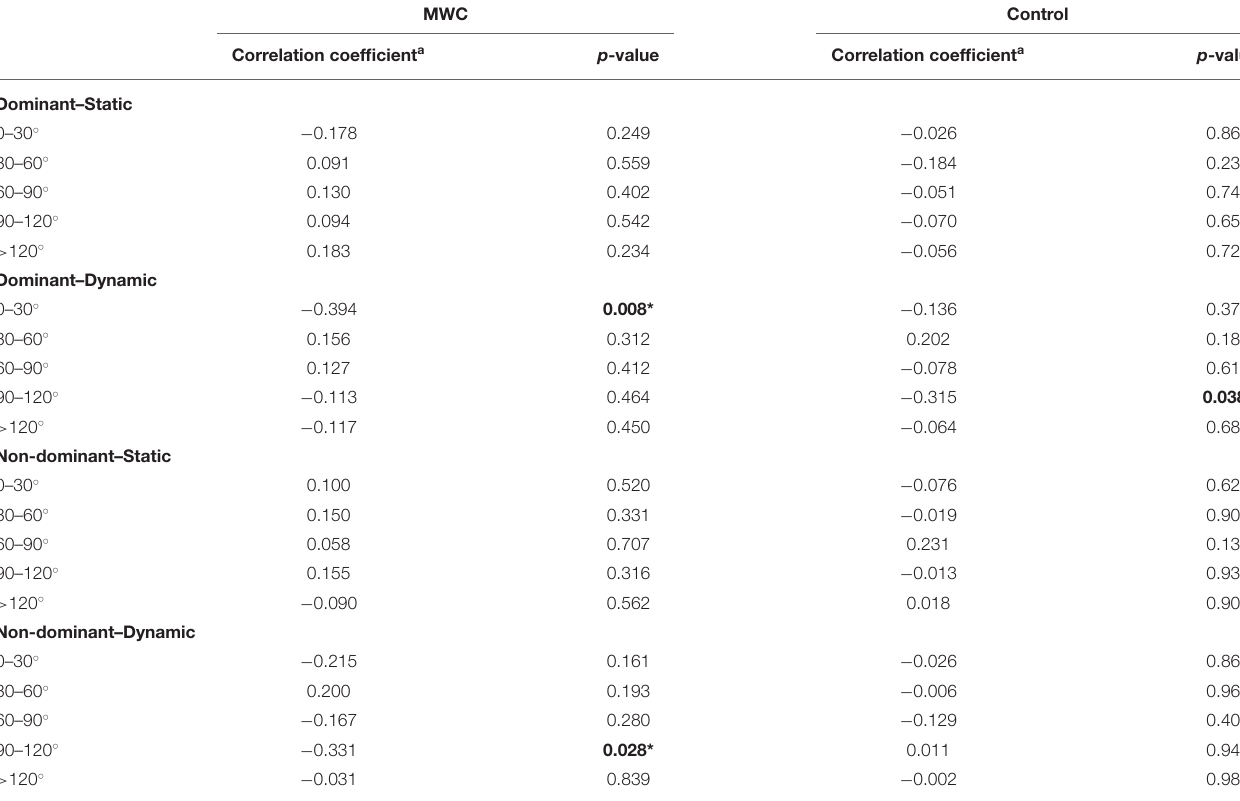
TABLE 5 | The correlation coefficient between age and the average consecutive duration of static and dynamic periods in each humeral elevation range for the MWC and control cohorts.